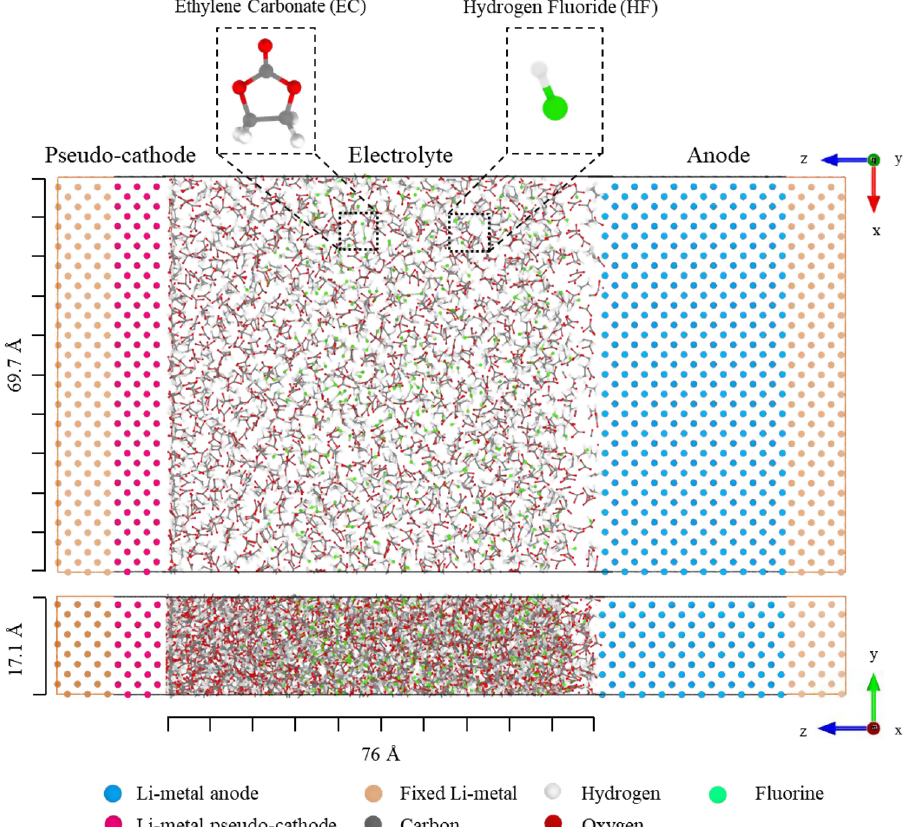
Fig. 1 Front and side views of the initial composition of the simulated nano-battery cell. From left to right, the pseudo-cathode, electrolyte, and lithium metal